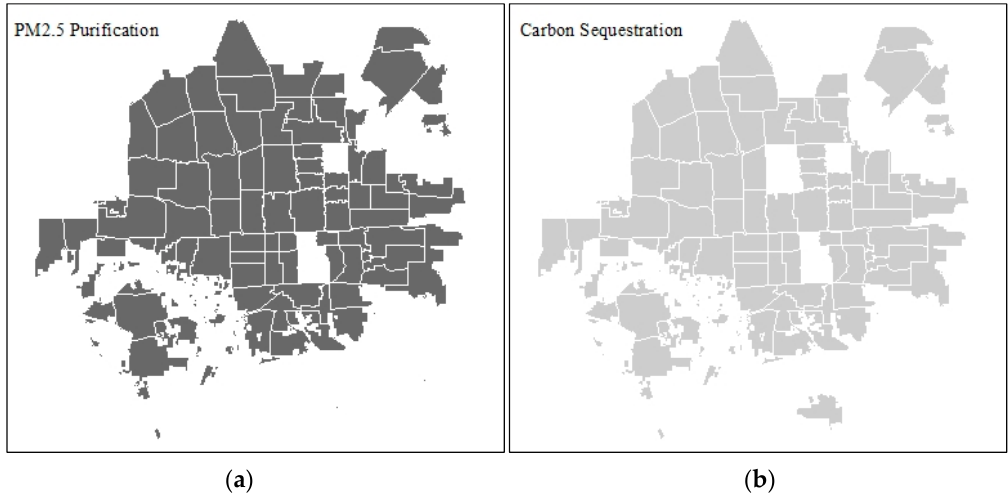
Figure 9. Sub-districts with unbalanced supply and demand of ( a ) purification service for particulate matter with an aerodynamic diameter < 2.5 µm (PM 2.5 ) and ( b ) carbon sequestration service.